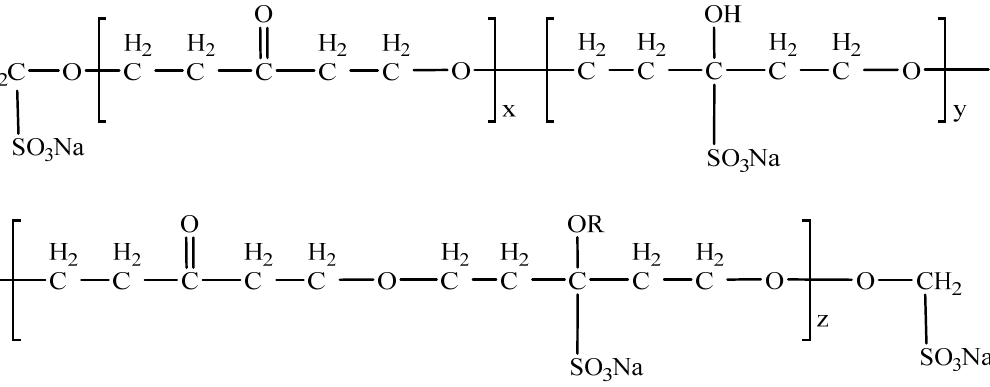
Figure 1. Chemical structure diagram of sulfonated acetone formaldehyde condensate (SAF).